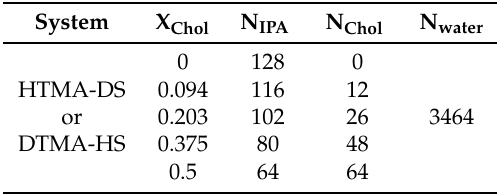
Figure 1. Molecular structures of HTMA-DS, DTMA-HS IPA complexes, and cholesterol. The representative bilayer structures of pure IPA and IPA-Chol systems are also shown, where the molecule color codes are: alkyltrimethylammonium in blue, alkylsulfate in yellow, and cholesterol in red. Graphics were generated using VMD package [30]. Table 1. Compositions of bilayer systems comprising HTMA-DS or DTMA-HS IPA, cholesterol (Chol) and water with the mole fraction of cholesterol (X Chol ) ranged from 0 to